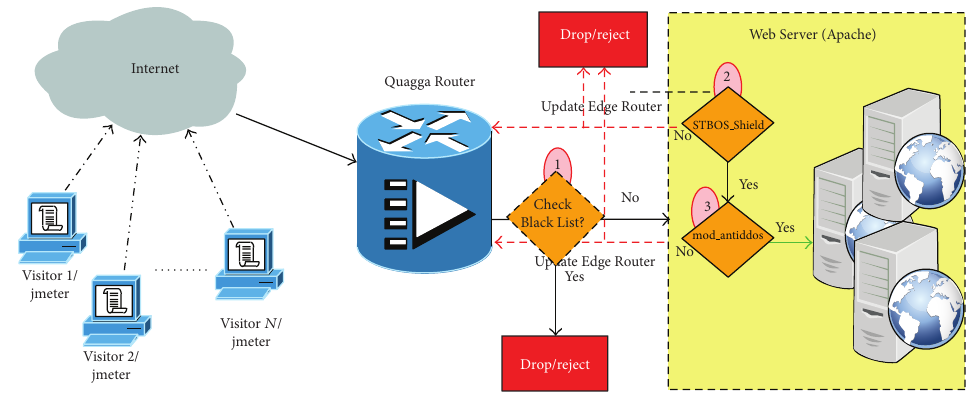
Figure 8: The construction simulation